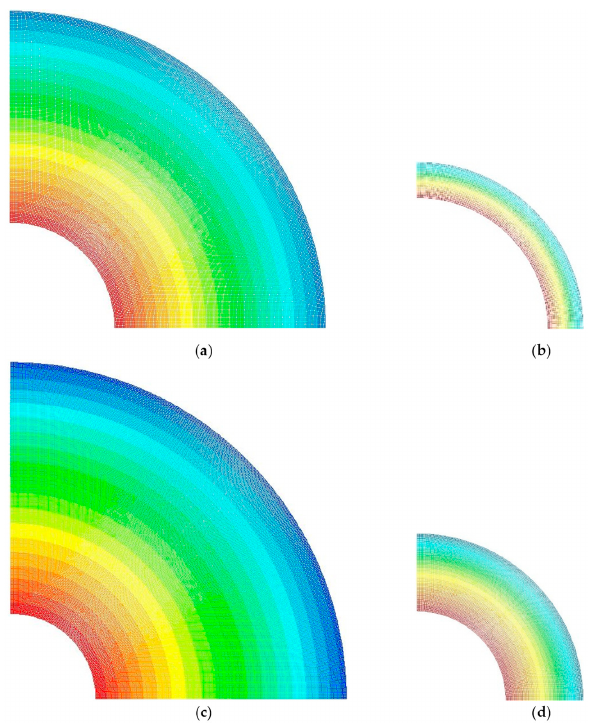
Figure 8. Temperature field based on simulation results for pipe temperature 300 and 600 °C: ( a ) Basalt fiber, T p = 300 °C; ( b ) Aerogel, T p = 300 °C; ( c ) Basalt fiber, T p = 600 °C; ( d ) Aerogel, T p = 600 °C. Further, we made calculations for the use of the investigated insulating materials for the pipe temperature range from 150 to 600 °C. We also consider a wide range of insulat- ing material thicknesses, from 5 mm to 80 mm for aerogel and from 25 mm to 250 mm for basalt fiber. Figure 9 shows the obtained results of the temperature on the surface of the insulating material, depending on the thickness of the insulation. The curves are pre- sented for different temperatures of the heated pipe.